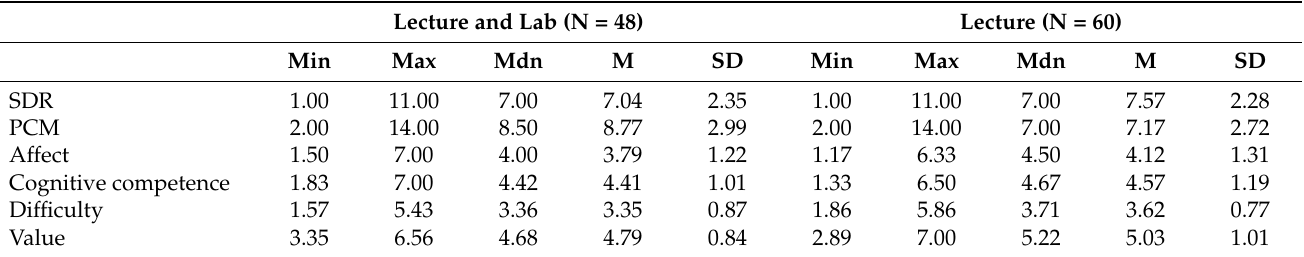
Table 1. Descriptive statistics of the variables in the two groups.